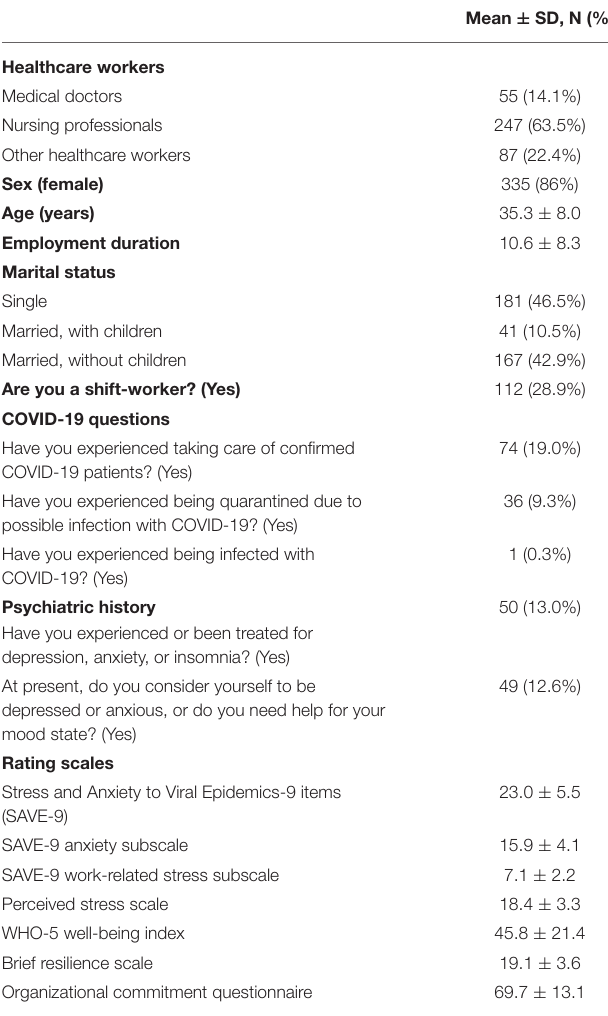
TABLE 1 | Demographic characteristics of the participants ( N =